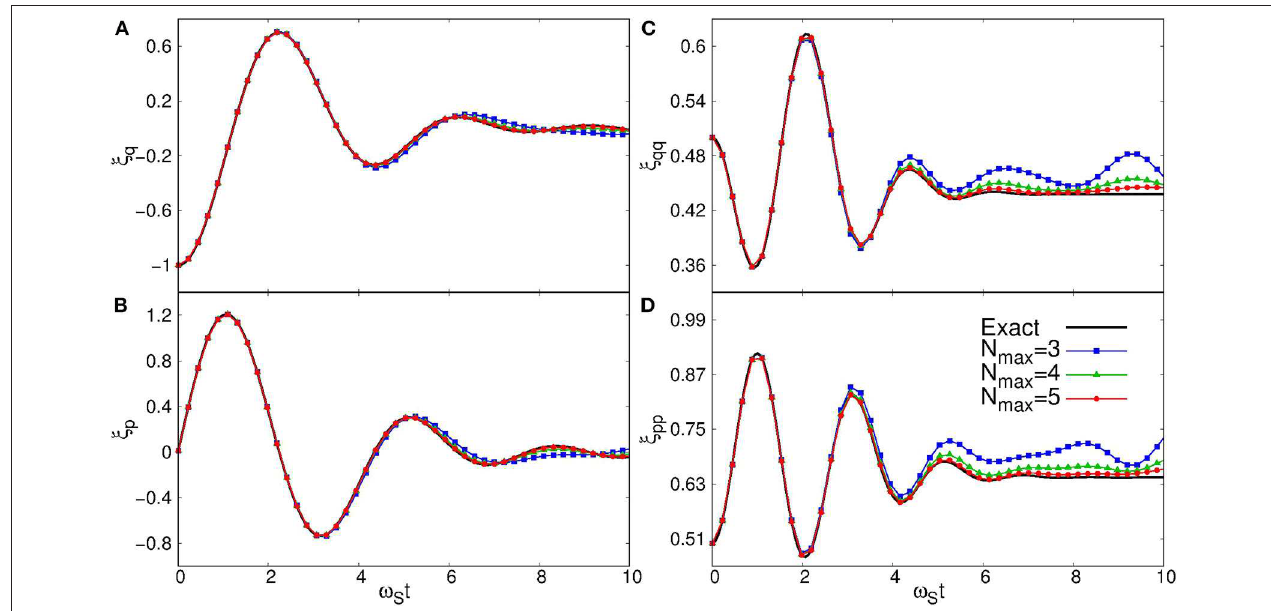
q p q S / h , / q S , (B) ξ p = h i = h i ¯